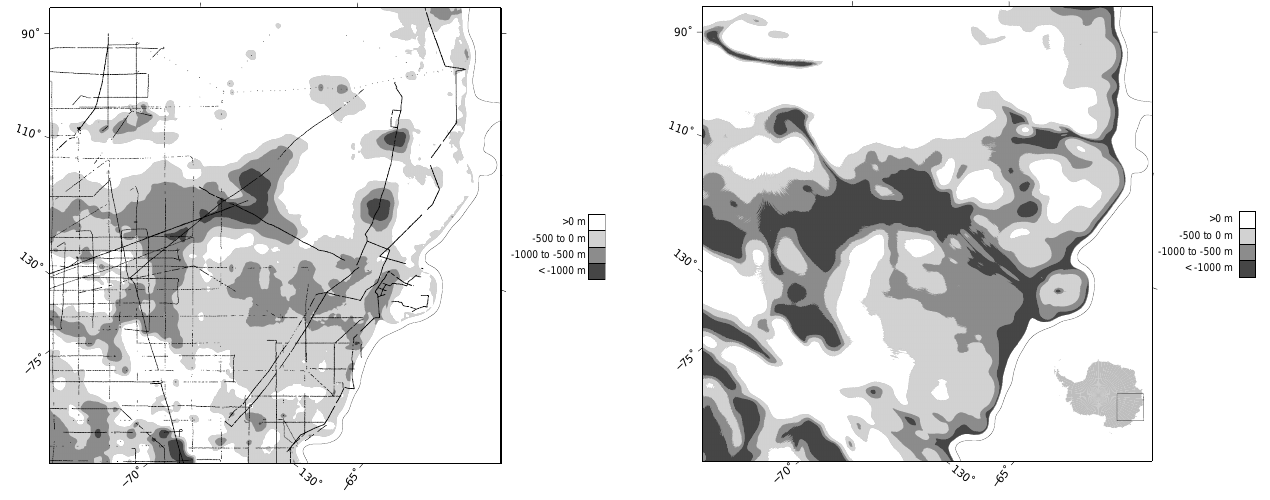
Fig. 1. BEDMAP ice sheet bed elevation, the location of prior data- sets is also shown. The horizontal reference coordinate system used herein is a polar stereographic projection with 71 ◦ S as the latitude of true scale and 0 ◦ E as the central meridian. The vertical coordi- nate is relative to the GGM01C geoid.